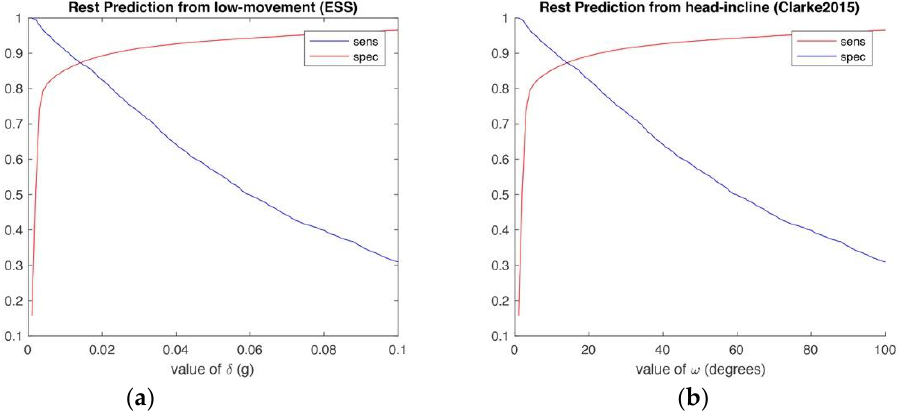
Figure 3. ( a ) ROC approach to find the optimal movement threshold of δ for rest and non-rest classification using the ESS approach; ( b ) ROC approach to determine optimal angle of ω for classification of head-up vs. head-down while recumbent as in Clarke and